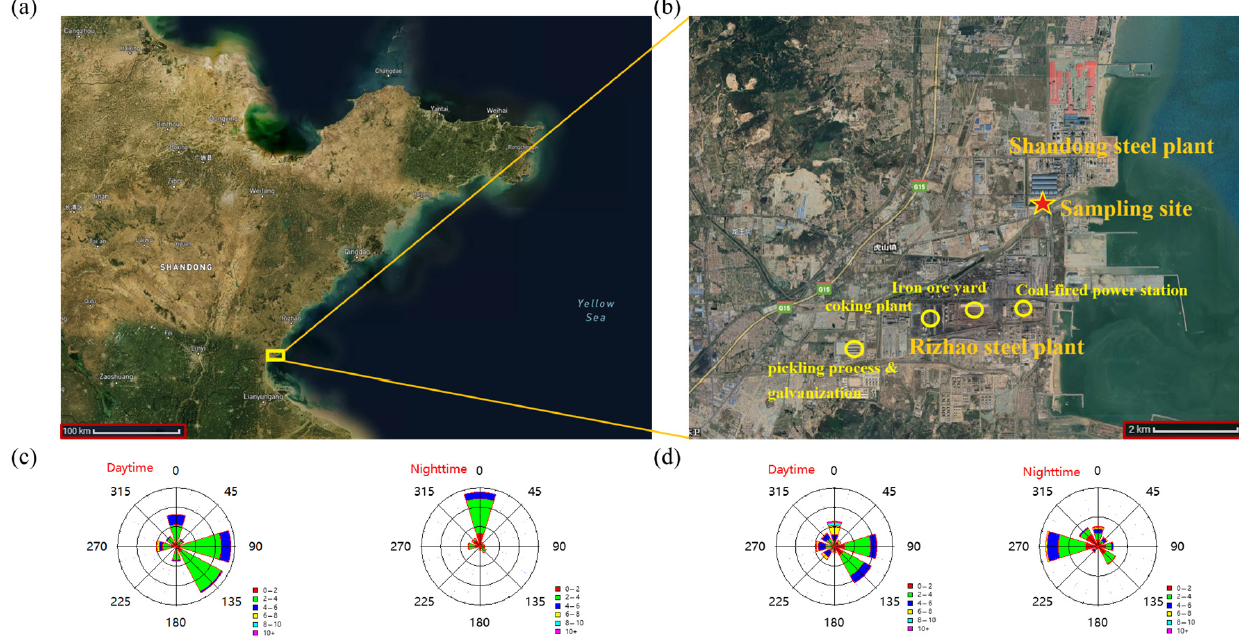
Figure 1. (a, b) Location of the sampling site (© Google Earth). Panels (c) and (d) show wind rose plots of daytime and nighttime for the entire study in September 2018 and March 2019,